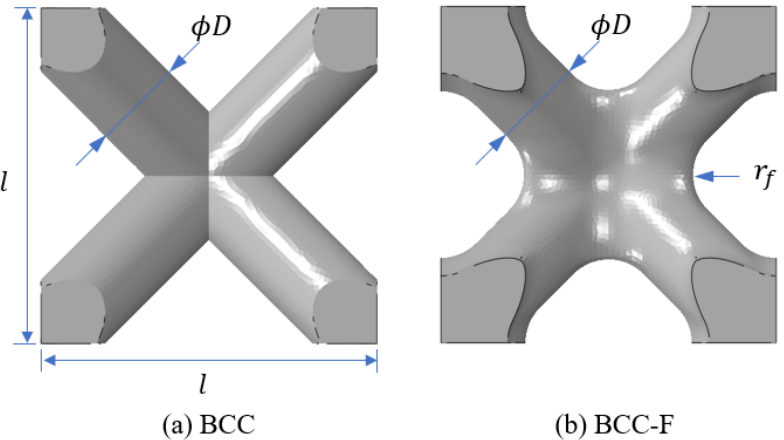
Figure 2. Configurations of ( a ) a BCC lattice cell and ( b ) a BCC-F lattice cell, shown in the front view, where l , D , and r f denote the length of the lattice cell, the lattice strut diameter, and the fillet radius, respectively.